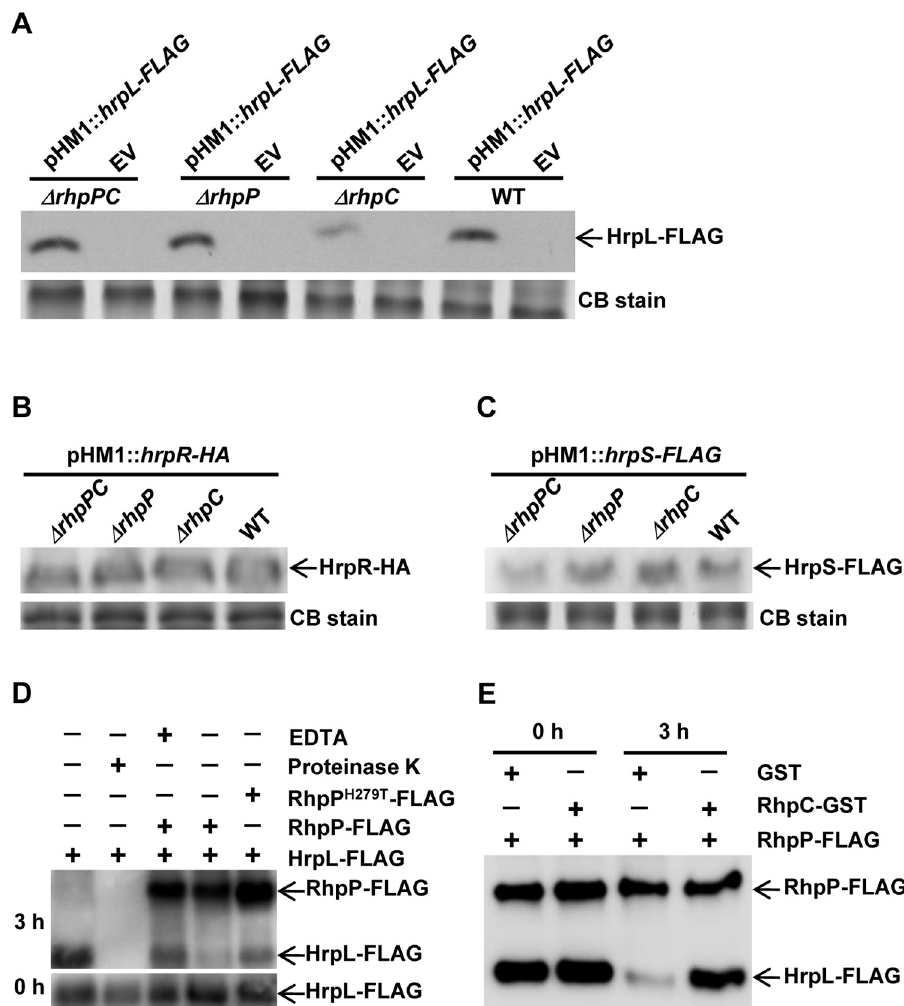
Fig 6. RhpP alone in Psph decreased the protein level of HrpL but not HrpR and HrpS. (A-C) HrpL-FLAG, HrpR-HA, and HrpS-FLAG were expressed in Psph , Δ rhpC , Δ rhpP , and Δ rhpPC strains using the broad host pHM1 plasmid under a constitutive promoter. The HrpL-FLAG (A), HrpR-HA (B), and HrpS-FLAG (C) protein levels were examined using Western blot with anti-FLAG and anti-HA antibodies. Empty pHM1 plasmid (EV) was also introduced into the bacterial strains as control. (D) In vitro digestion of HrpL protein by RhpP. RhpP-FLAG and RhpP H279T -FLAG proteins produced by the pHM1 plasmid were purified from the Psph strain. HrpL-FLAG protein produced by the pHM1 plasmid was purified from E . coli BL21 strain. The purified HrpL-FLAG was incubated with RhpP-FLAG, RhpP-FLAG plus EDTA, and RhpP H279T -FLAG in PBS buffer at 28˚C for 3 h, and then examined by Western blot analysis. HrpL-FLAG incubated with protease K or PBS buffer alone was used as control. 0 h shows the initial level of HrpL protein in each reaction. (E) Inhibition of the RhpP-mediated degradation of HrpL by RhpC. The purified HrpL-FLAG was incubated with RhpP-FLAG plus purified RhpC-GST or GST for 0 and 3 h, and then examined by Western blot analysis with anti-FLAG antibody. CB stain, Coomassie Blue stain.